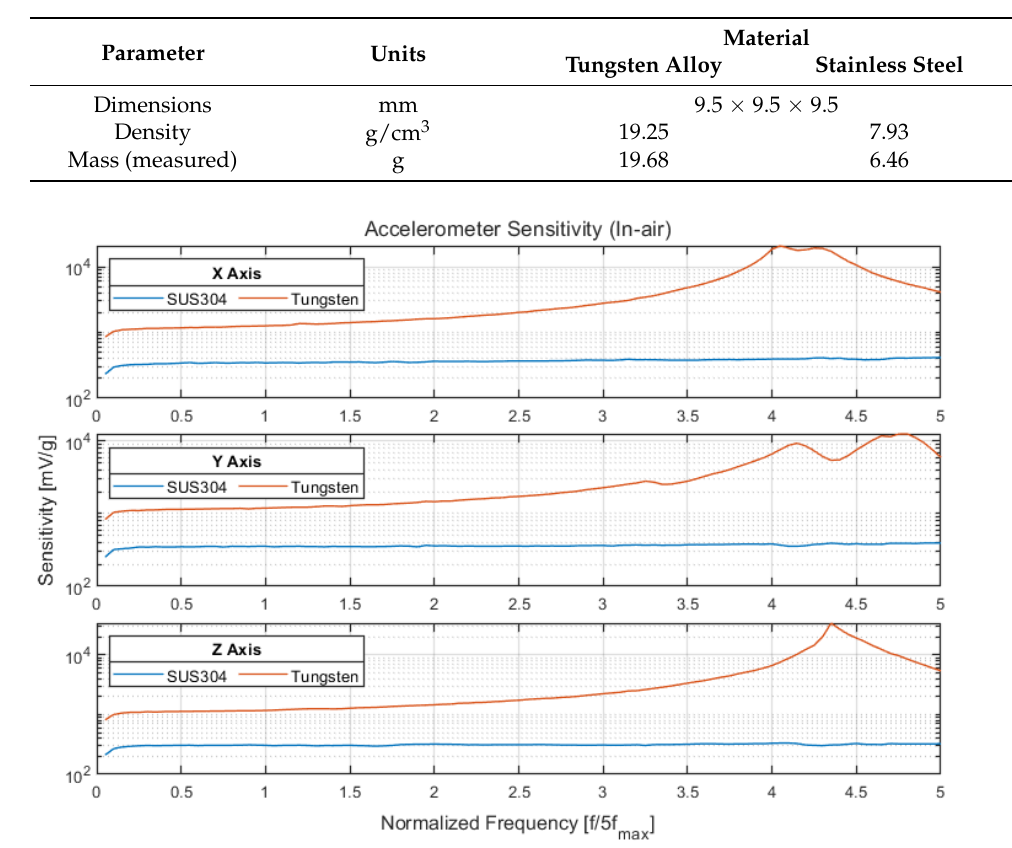
Figure 7. Sensitivity of accelerometer with a stainless-steel or tungsten alloy seismic mass.